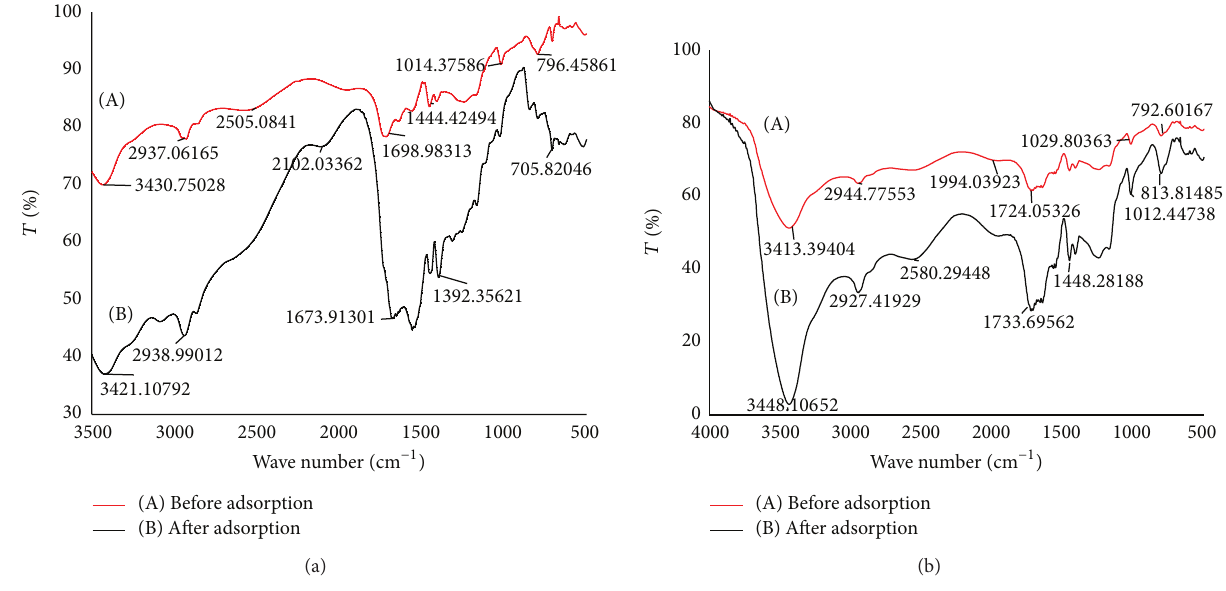
Figure 4: IR spectra of D155 (a) and HZD-3B (b) resins before and after 𝜀 -PL